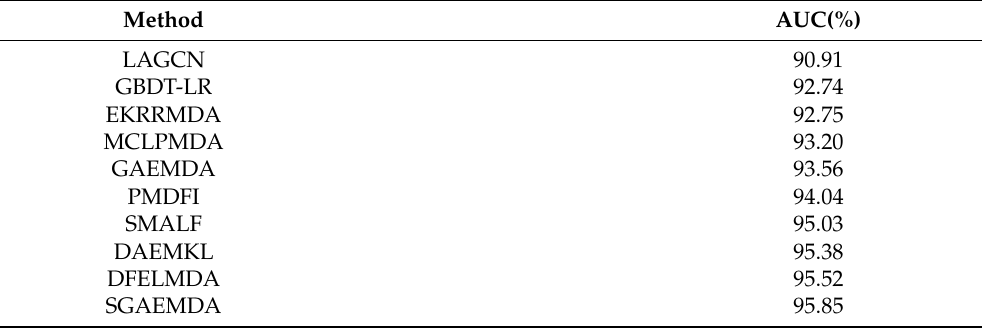
Table 4. Comparison of different methods based on 5-fold